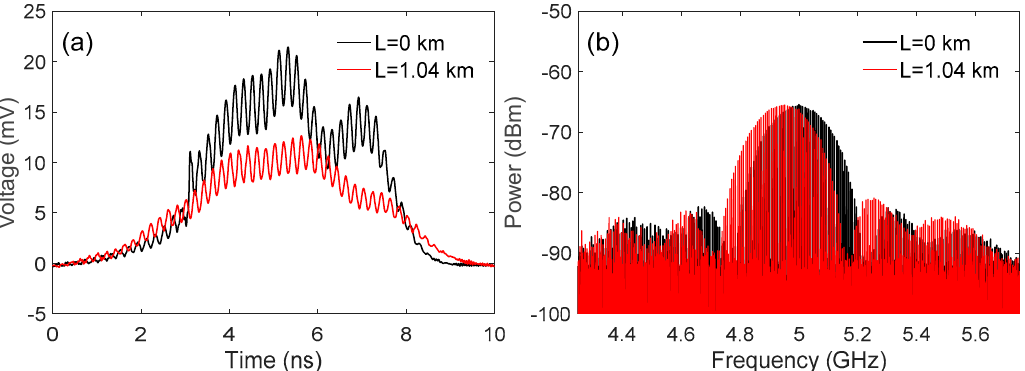
Figure 7. ( a ) The waveform of the pulse when the length of SMF was 0 km and 1.04 km; ( b ) the electrical spectrum of the frequency conversion system.